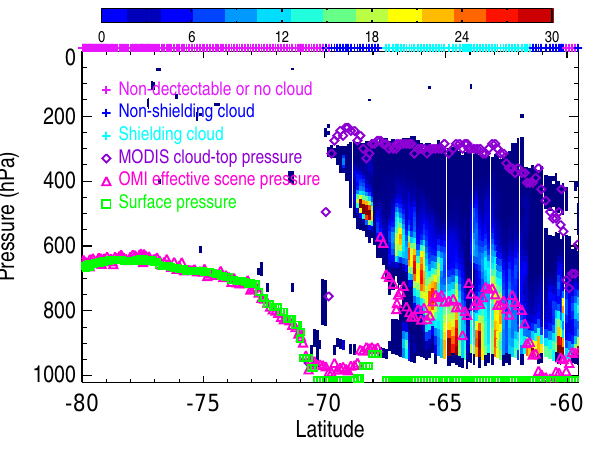
Fig. 10. As in Fig. 9 but for OMI orbit 12395.